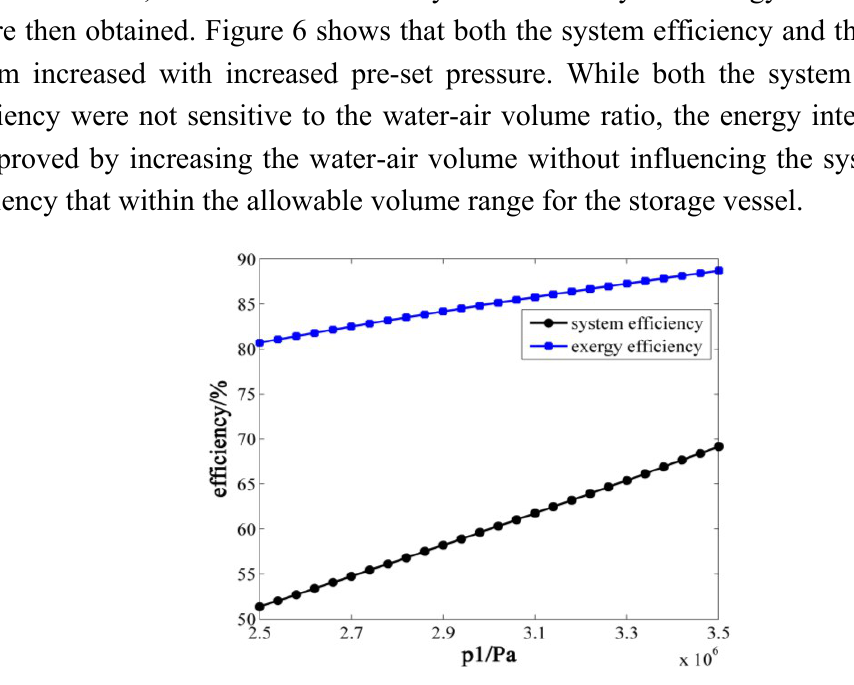
Figure 6. The variations of system efficiency and exergy efficiency with pre-set